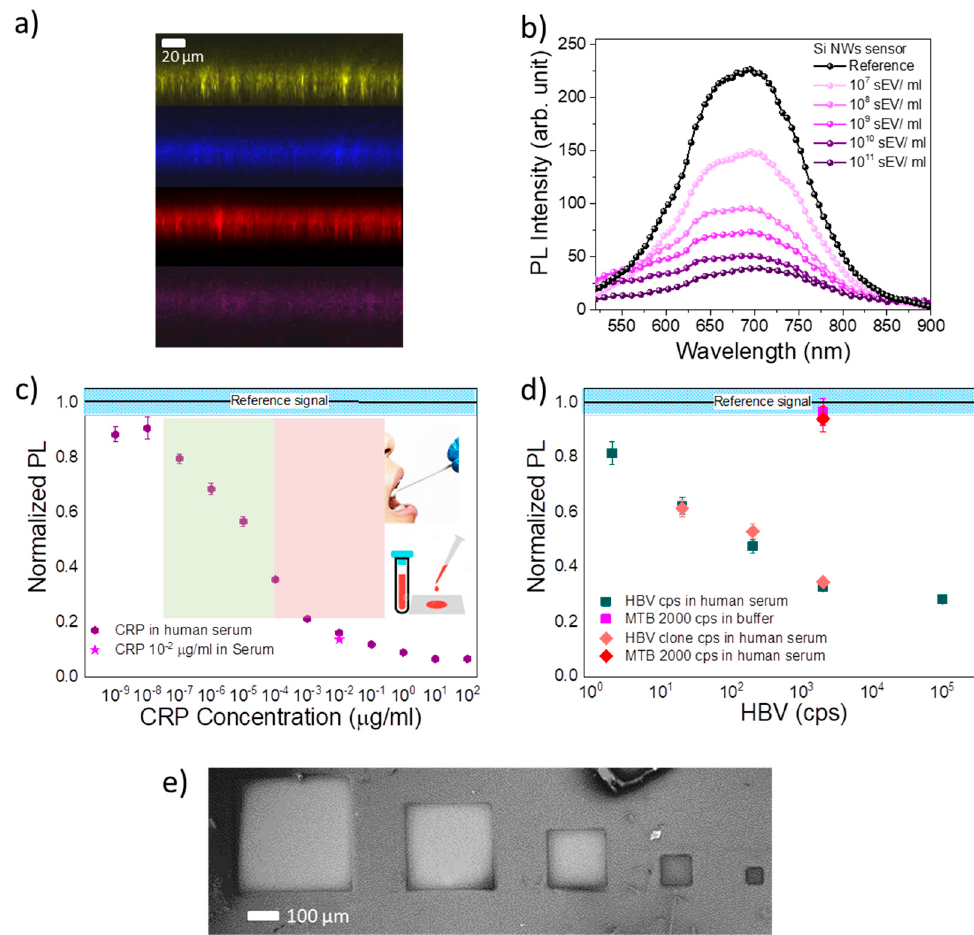
Figure 4. ( a ) Confocal microscopies of all the functionalization steps for sEV detection by using different fluorophores: bare Si NW with yellow emission, SA emission in blue obtained exciting its Alexa488 marker, anti-CD81 emission in red obtained exciting its marker fluorophore Alexa 647, sEVs CD81 + capture by using NBD-PE-marked sEVs whose emission is shown in purple. ( b ) Photoluminescence quenching of the NW sensor for different sEV concentrations. ( c ) Calibration curve of NW sensor for C-reactive protein detection. ( d ) Calibration curve of NW sensor for Hepatitis B Virus. ( e ) SEM plan-view microscopy of squared wells for the Si NWs local synthesis for optical biosensor arrays realized by 365 nm optical lithography process in hard contact mode with a Karl Suss MA6 tool.